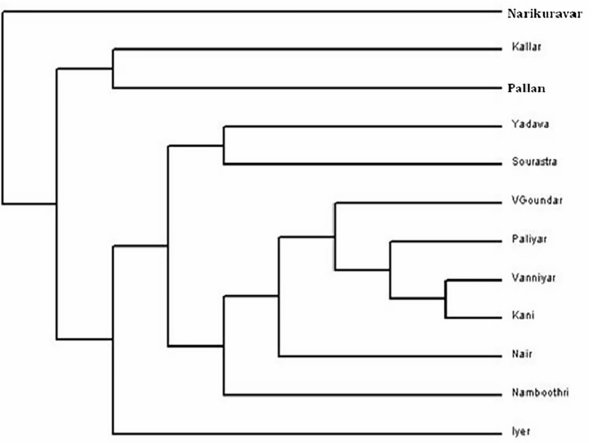
Fig 3. Neighbor joining tree of 10 caste and 2 tribal populations of Tamil Nadu based on Alu